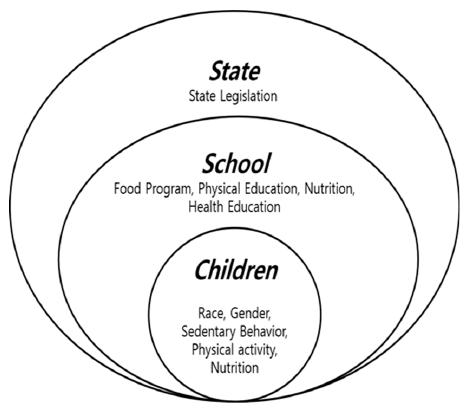
Figure 1. The adopted ecological system theory from Bronfenbrenner (1979, 1989).